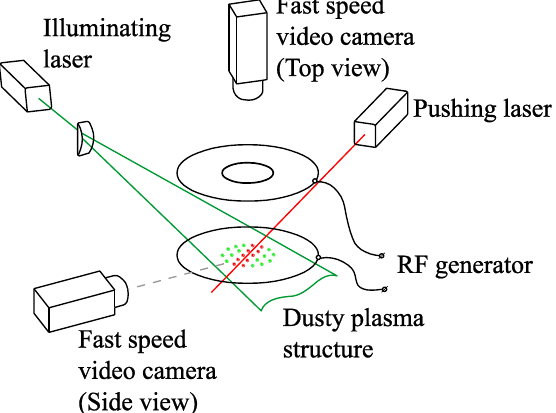
Figure 6. A scheme of the experimental setup for studying the colloidal plasma in a RF discharge under laser irradiation.